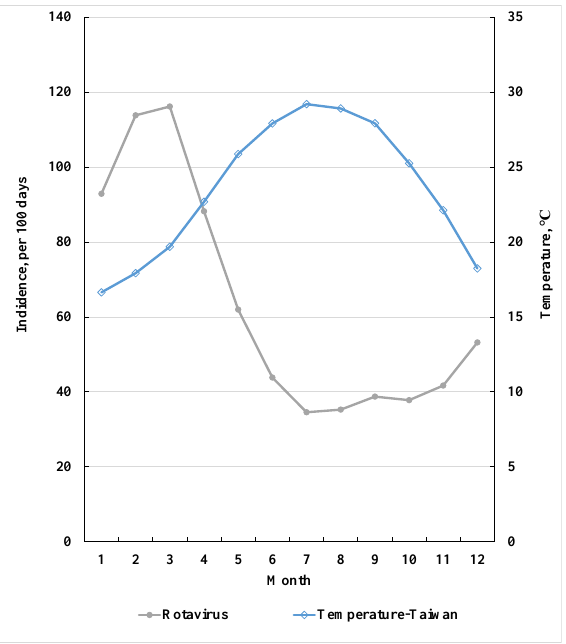
Figure 1. Relationship between monthly mean childhood rotavirus infection and average temperature in 2006 – 2012 in Taiwan. Table 1. Multivariable Poisson regression analysis estimated adjusted relative risk of rotavirus in- fection by temperature, PM 2.5 , and parental annual income. Infection, Relative Risk 1 Variable n /100 Days (95% Confidence Interval) Average daily temperature, °C <15